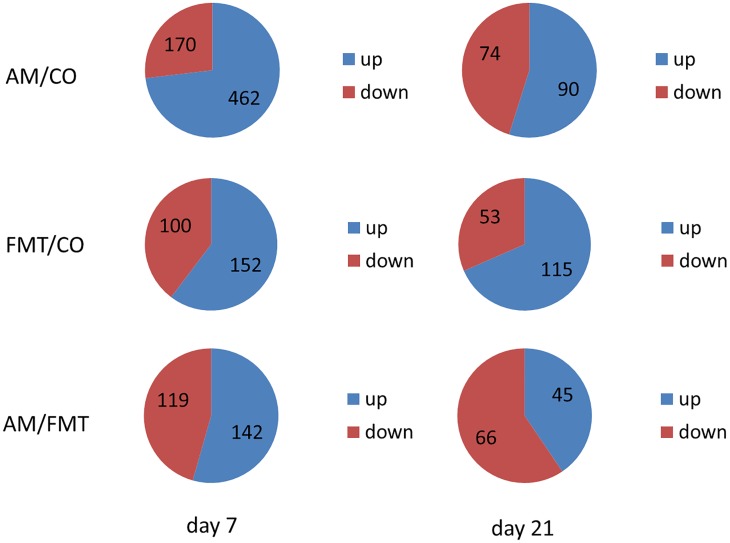
Number of the total differentially expressed genes (DEGs) as well as the up- and downregulated genes in the livers of pigs among the AM, FMT and CO groups on days 7 and 21.